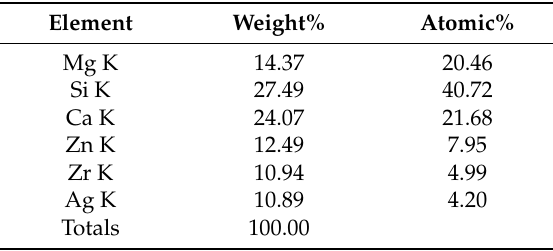
Table 2. Composition of region